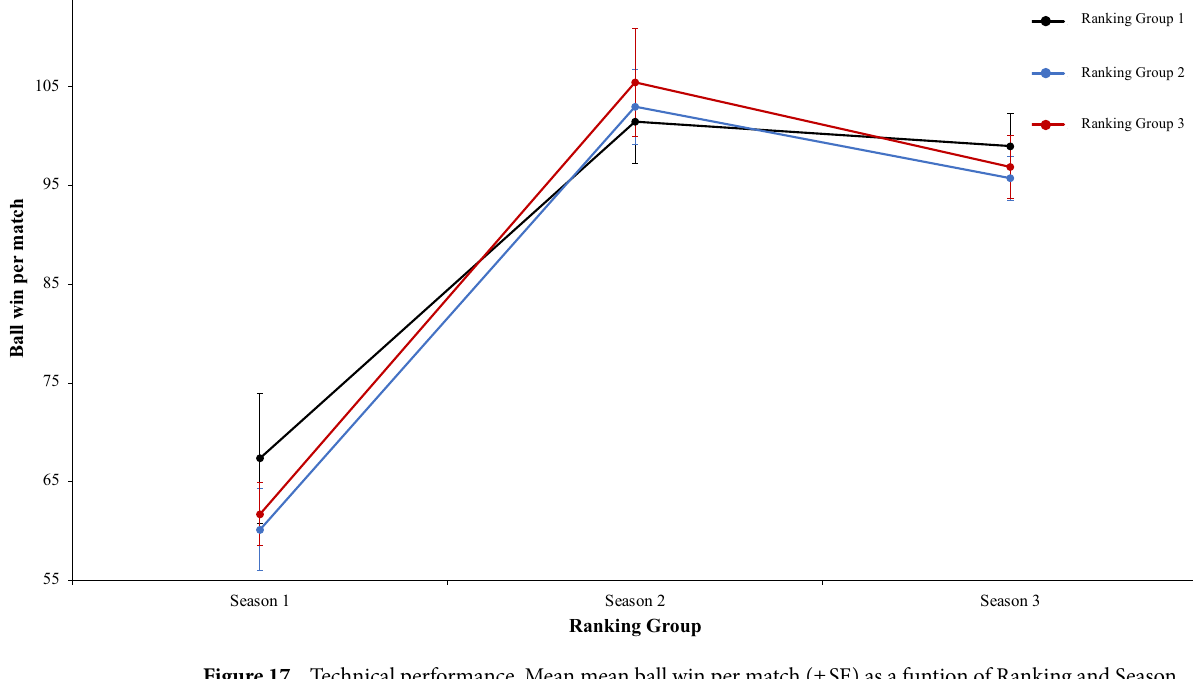
Figure 17. Technical performance. Mean mean ball win per match (± SE) as a funtion of Ranking and Season Condition.